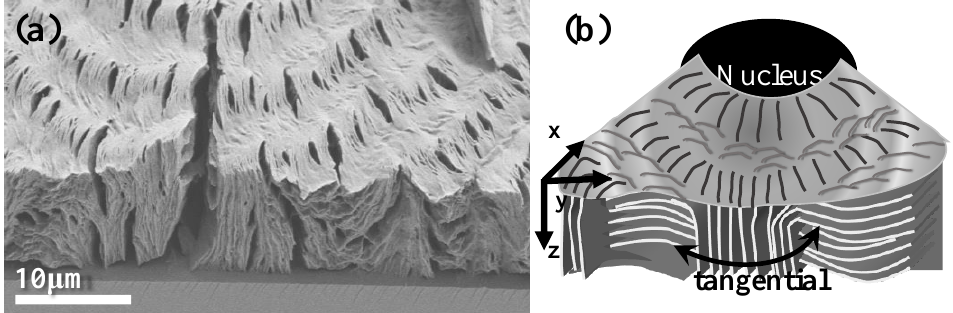
Figure 4. ( a ) SEM graph of tangentially-fractured interior surface of PBA banded crystals crystallized from PBA/PEO (90/10) at 30 °C and ( b ) schematics for correlation between the interior lamellae and top-surface ring bands.